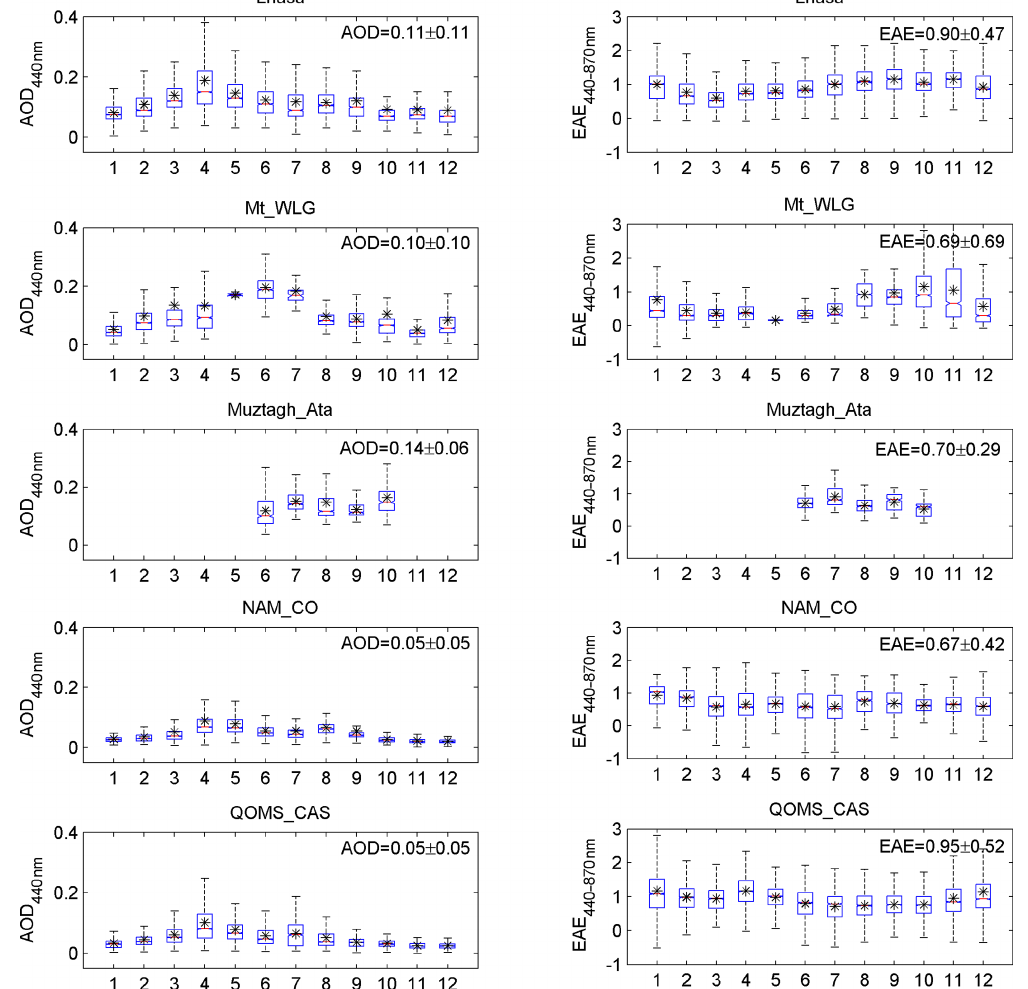
Figure 2. Box plots of the monthly aerosol optical depth (AOD) and extinction Ångström exponent (EAE) from CE318 at the five sites located on the Tibetan Plateau, i.e., Lhasa, Mt_WLG, Muztagh_Ata, NAM_CO and QOMS_CAS. In each box, the red line in the center is the median, and the lower and upper limits are the first and the third quartiles, respectively. The lines extending vertically from the box indicate the spread of the distribution with the length being 1.5 times the difference between the first and the third quartiles. The asterisk symbols indicate the geometric means in each month. The annual mean values and errors are also shown in each